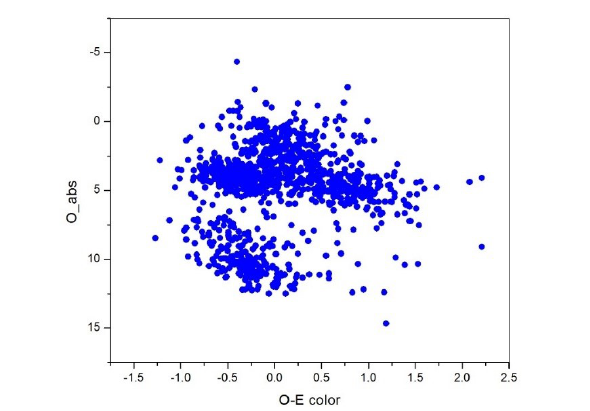
Figure 3. SDSS color-color diagram for McCook and Sion Catalogue 4468 WDs Figure 4. MAPS color-magnitude diagram for FBS BSOs. WDs